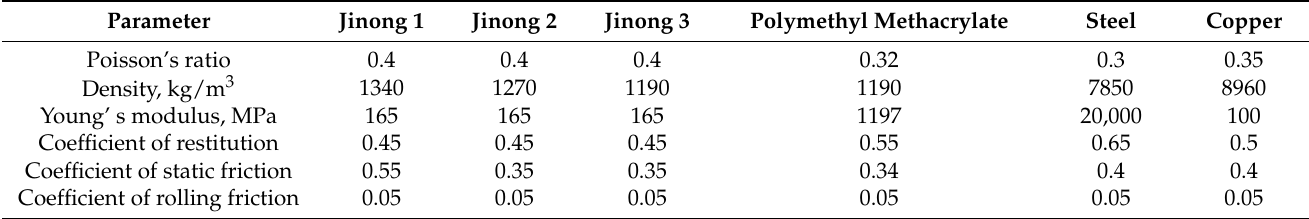
Table 6. Simulation parameters of the tests [22].